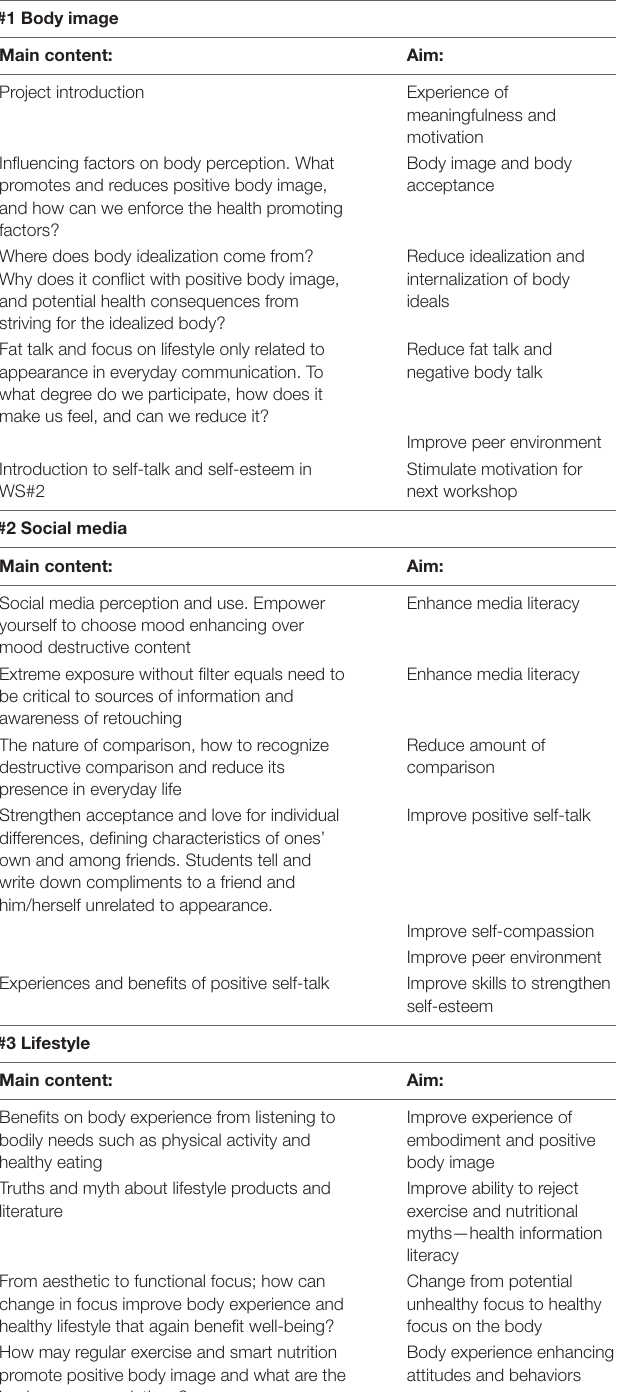
TABLE 1 | Overview of the content and aims of the three workshops in the HBI